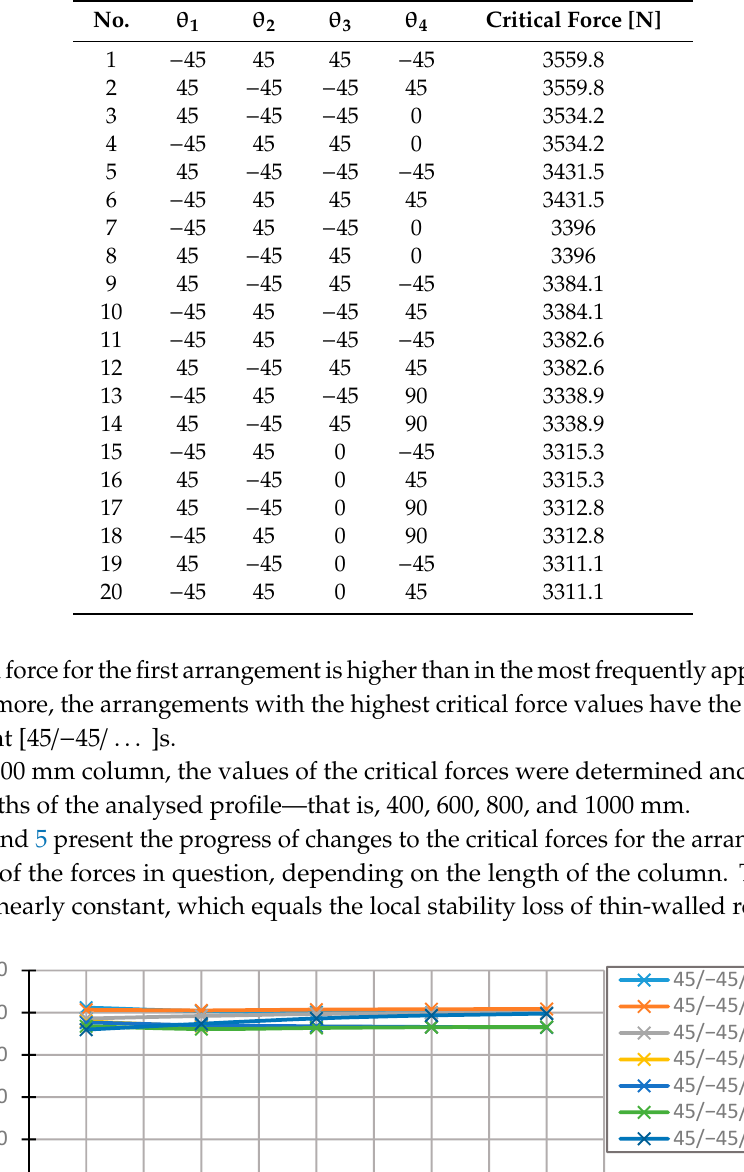
Table 2. Arrangement of the layers with the highest values of the critical force.